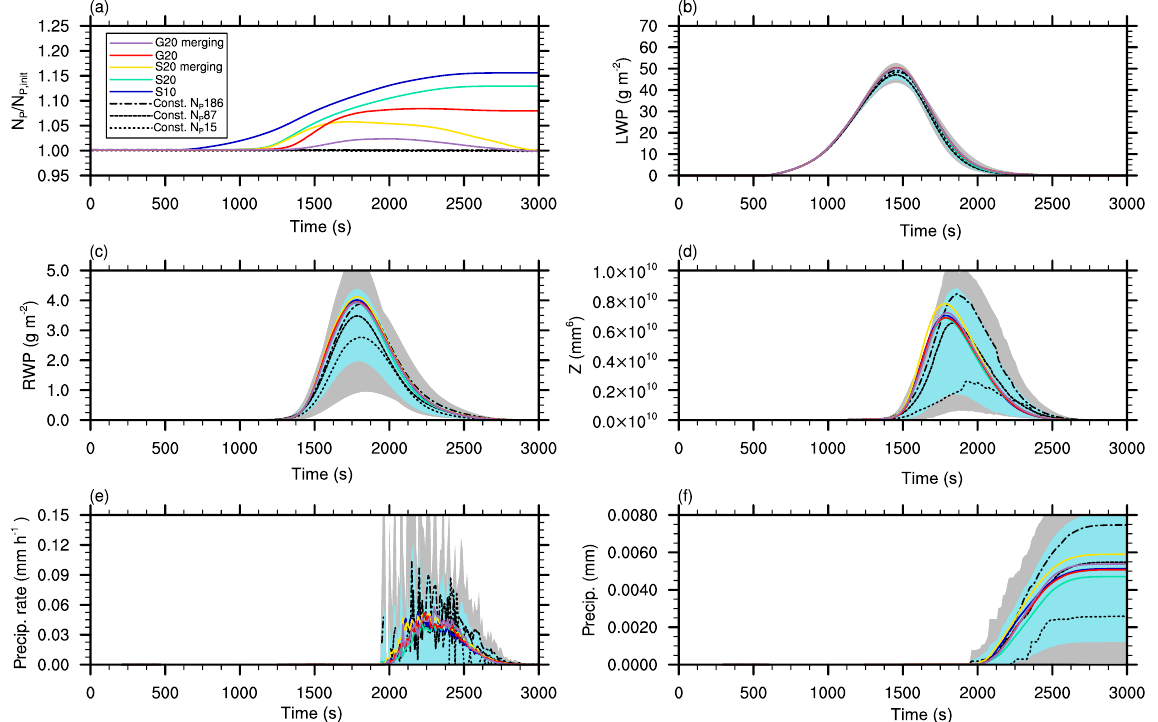
Figure 15. Time series of different variables for the idealized single-cloud simulation for different initial numbers of superdroplets and splitting configurations. In (a) , the ratio of the actual and initialized number of superdroplets in the whole model domain is shown. The liquid water path (LWP) and rainwater path (RWP) are displayed in panels (b) and (c) , respectively. In (d) , the total radar reflectivity is shown. Panels (e) and (f) show the precipitation rate and total precipitation, respectively. The reference simulations (runs without splitting) are presented as a mean of five ensembles for each case. Moreover, the light blue areas show the mean plus–minus one standard deviation and the gray areas show the range derived from all 15 ensemble members.